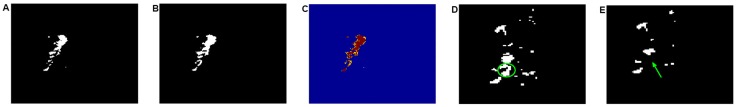
Illustration of an invasive ductal carcinoma (case V).(A)-(E) Segmented tumours using FCMs and the proposed hybrid classification, overlapping images, and depiction of noisy voxels from imaged fatty tissue, using both classification methods. The disconnected tumour voxels seen in (D), indicated by a green circle, are identified as a connected tumour component attached to the major tumour region, the reconstruction is performed using the proposed hybrid classification, these can also be seen in (E) next to the green arrow.